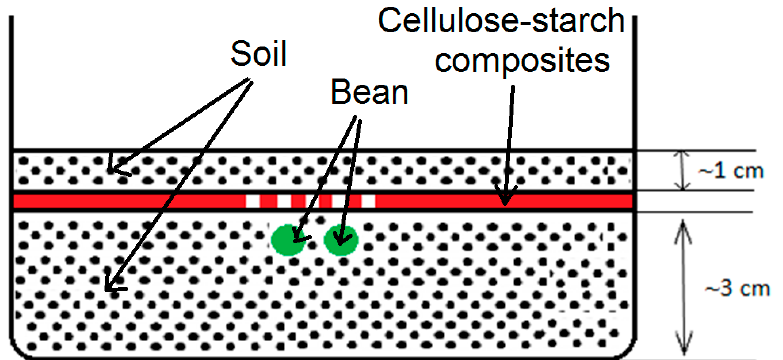
Figure 13. Scheme showing the sowing of legumes ( Phaseolus vulgaris ) on cellulose-starch composites.